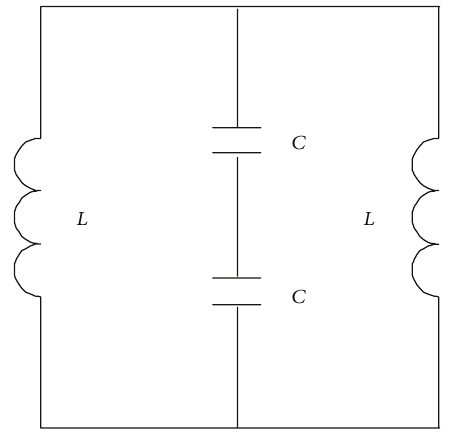
Figure 3: Equivalent model of square loop aperture element. Table 1: Parameters of the designed FSS element.